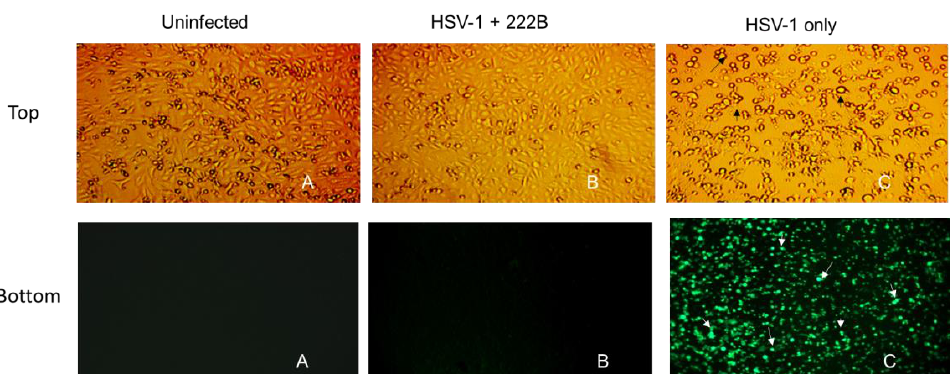
Figure 5. Electron micrograph images of HSV-1 virions treated with different surfactants. The im- ages were HSV-1 virions without treatment ( A ), virions treated with 0.009% of 222B ( B ), 0.009% of SDS ( C ), and 0.009% of Triton X-100 ( D ), respectively. The black arrow indicates the capsids of vi- rions without envelopes. The white arrow indicates the envelope of the virion. Scale bar = 0.5 μm.